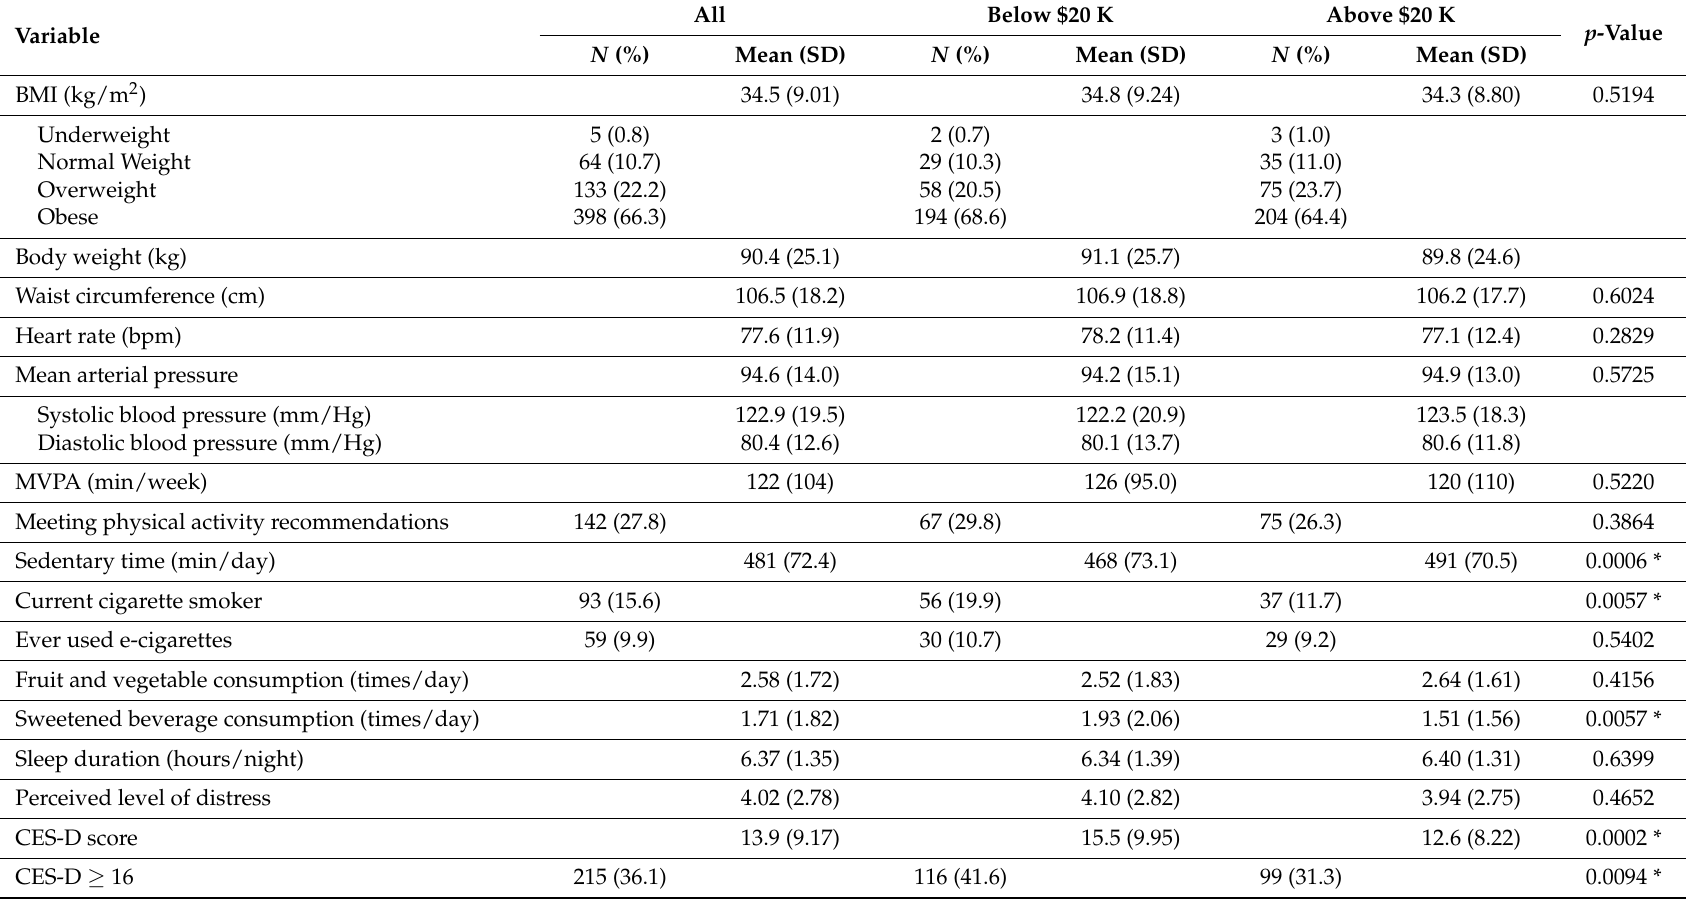
Table 3. Physical and mental health risk